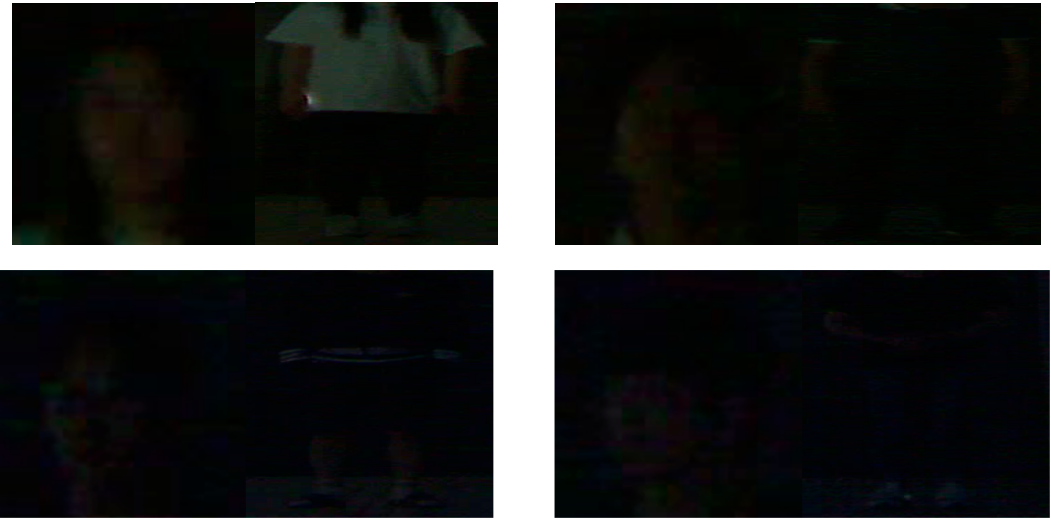
Figure 22. Examples of original images captured in real low-light environments.